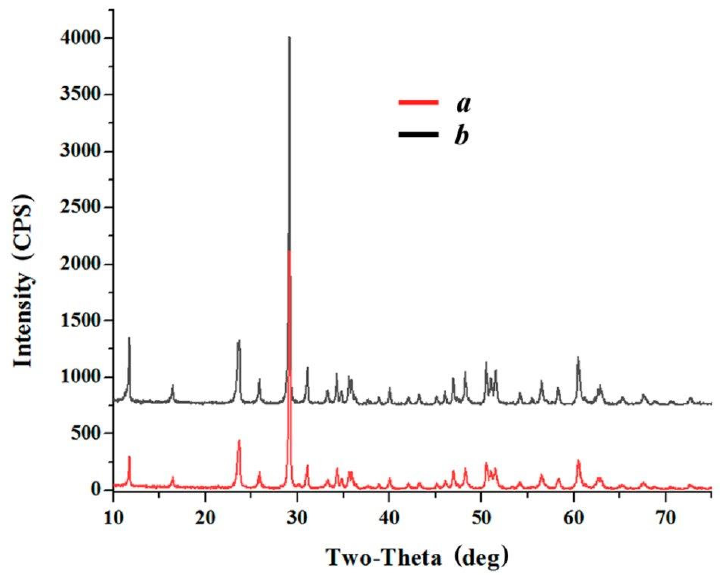
Figure 7. X-ray diffractograms of the calcium metaniobate obtained after holding LiNbO 3 powders in the melts of (0.40CaCl 2 -0.60KCl) at 750 ° С ( a ) and (0.35CaCl 2 -0.65LiCl) at 700 ° С ( b ) under air atmosphere for 7 h.